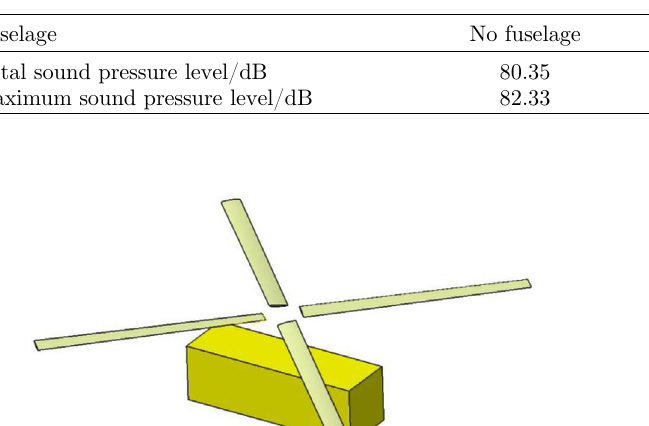
Figure 8. Scattering effects of different types of fuselage (XY graph). Table 2. Total and maximum SPL of helicopters with different fuselages.